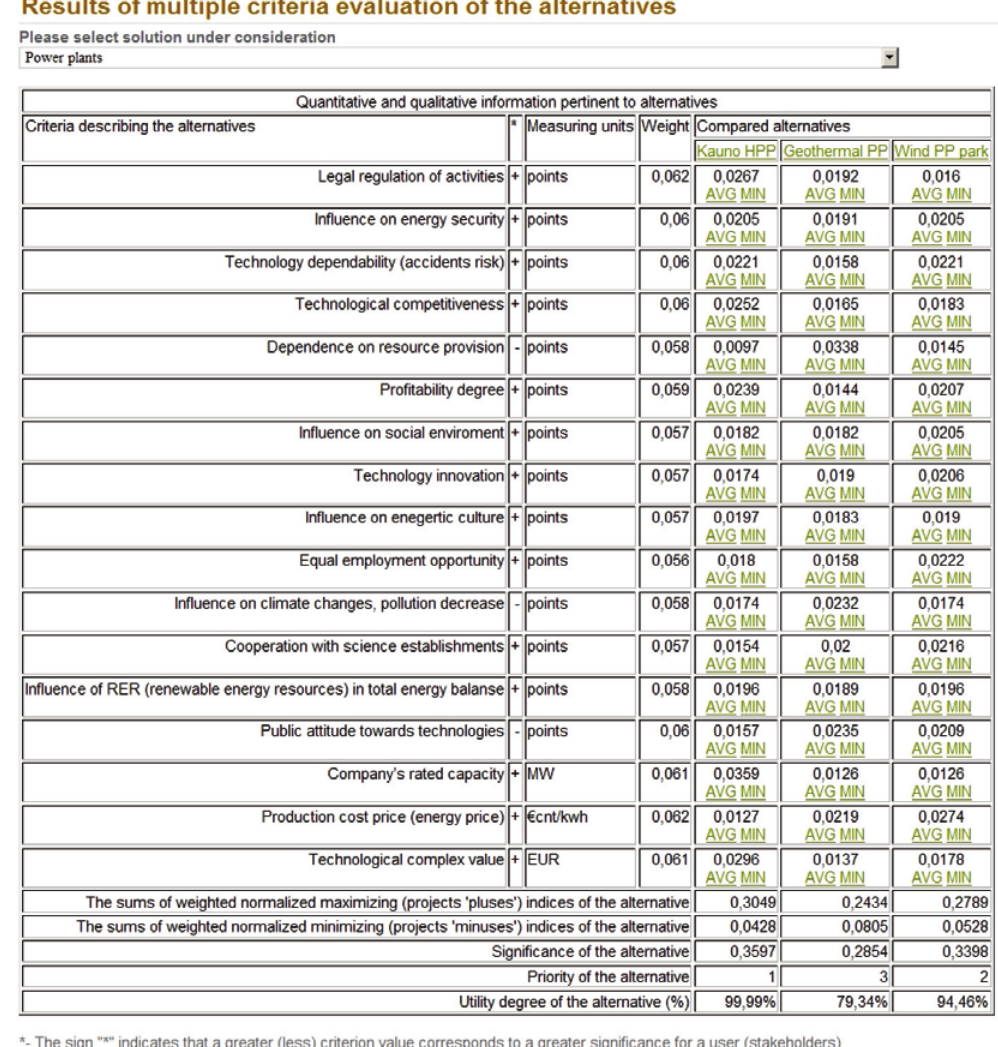
Figure 5. Determining the utility and priority of energy generation technologies, as well as the weights of criteria, in the